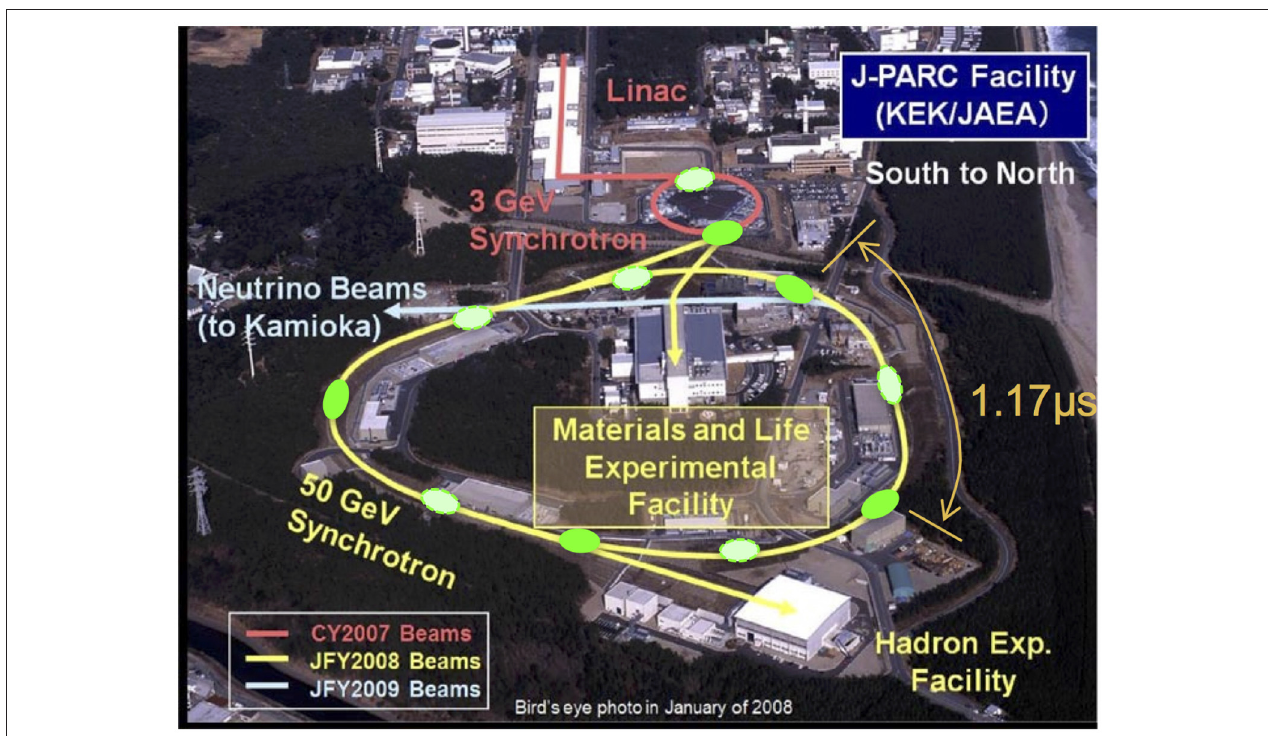
FIGURE 3 | The J-PARC facility. The primary proton driver LINAC and 3 GeV RCS beam lines are shown in red. The MR and related beamlines to NP hall where the COMET experiment locates (“Hadron experimental facility” at the bottom right) are shown in yellow. Note that maximum storage beam energy of MR is 50 GeV while the COMET experiment will use 8 GeV beam. The filled and hollow green circles around MR and RCS beamlines are filled and empty proton buckets, respectively. As written in the text, not all buckets are filled to maintain required bunch spacing between proton pulses. The photo credit of bird-eye view goes to